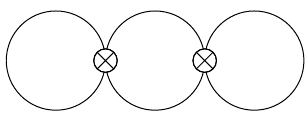
Figure 8 . Would-be leading order diagram